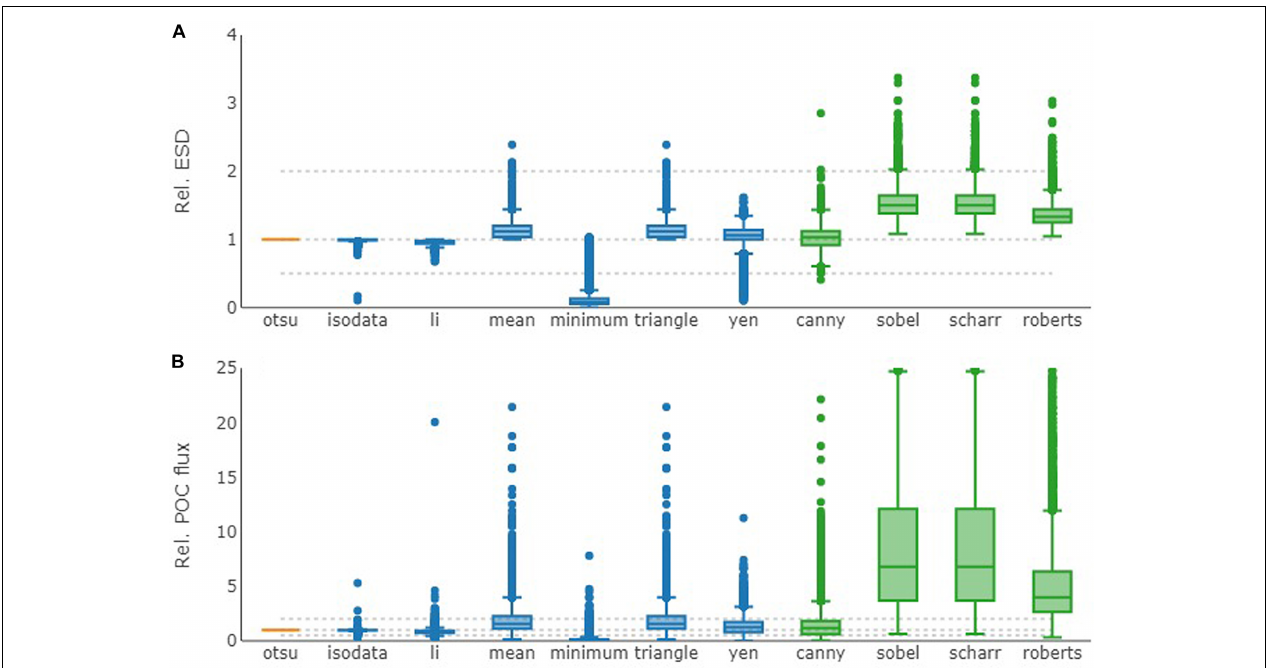
FIGURE 6 | Comparison of different threshold algorithms relative to Otsu. (A) Particle size (ESD in mm). (B) Average POC flux per particle (mg C m − 2 d − 1 ). Values are expressed as boxplots (see legend for Figure 5 ). Gray dashed lines indicate 0.5, 1, and 2 times Otsu value. Note the different y-axis scales. Colors show threshold algorithm type as orange (reference algorithm Otsu), blue (binary), and green (edge detection). Based on all imaged particles ( n = 6400).